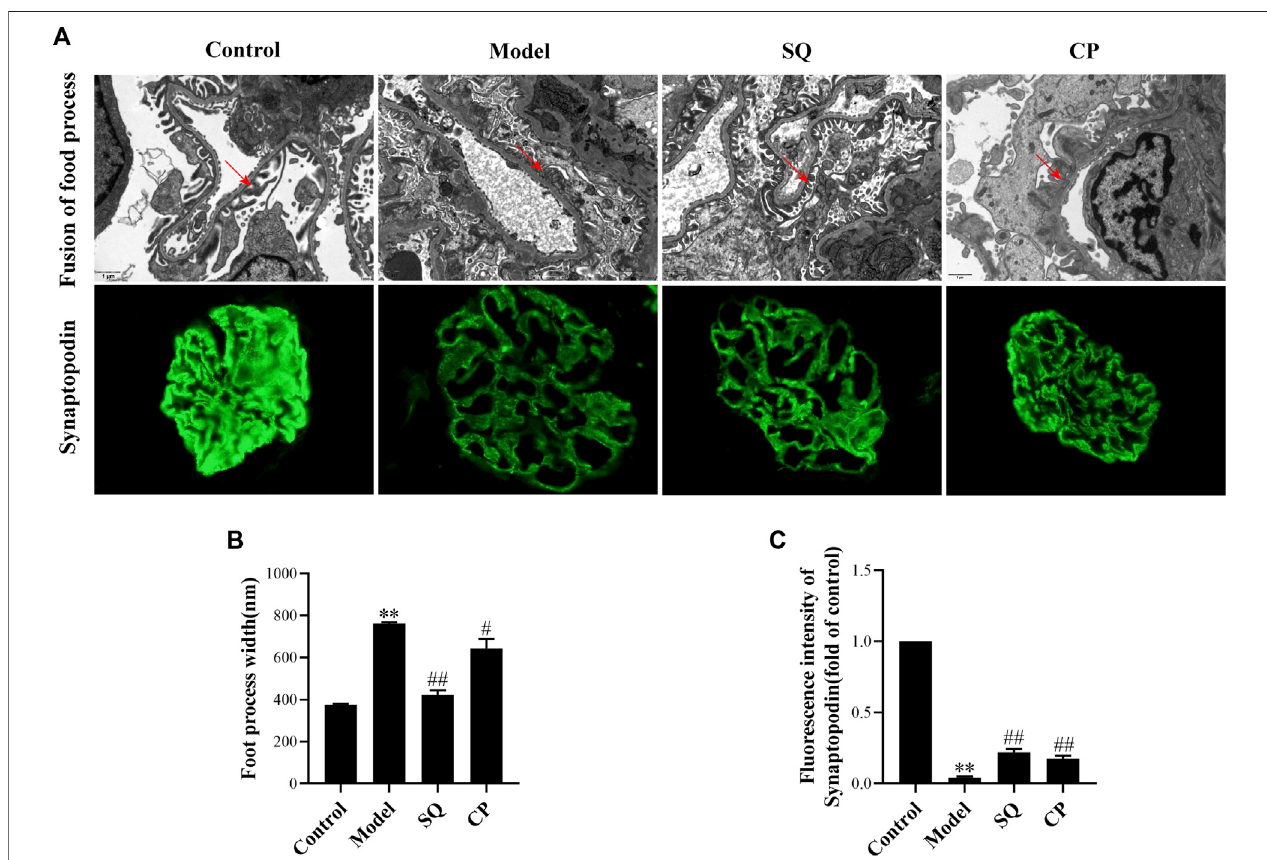
FIGURE 3 | SQ alleviated glomerular podocyte injury in PHN rats. Effects of SQ and CP on foot process width (magni fi cation × 12,000, red arrows) and synaptopodin expression (magni fi cation × 400) were measured by TEM and immuno fl uorescence staining (A) . With the treatment of SQ and CP, restored glomerular podocytic foot processes (B) and synaptopodin expression (C) wereseen inPHN rats ( n (cid:1) 6). Dataare represented asmean ± SD from independentgroups. ** p < 0.01 vs. Control group. ## p < 0.01 vs. Model group.